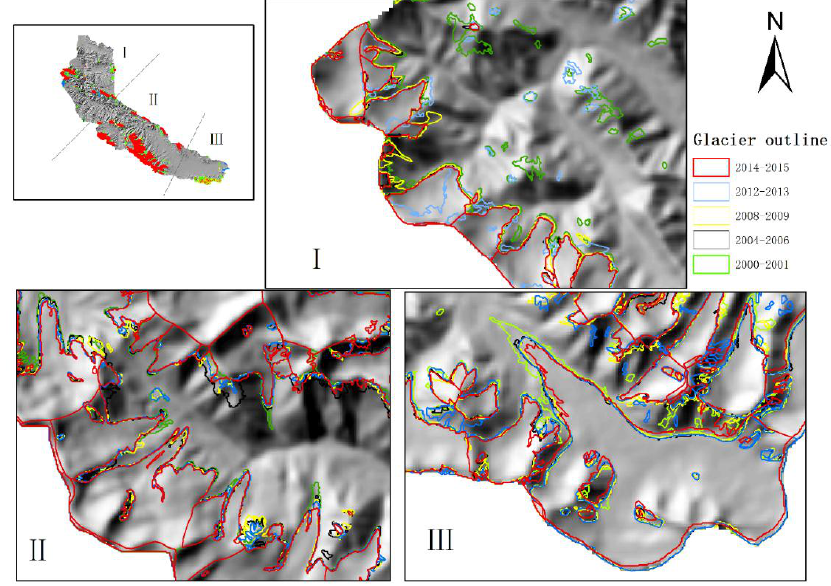
Figure 6. The glacier area changes in different subregions in the Upper Reach of Shule River Basin.